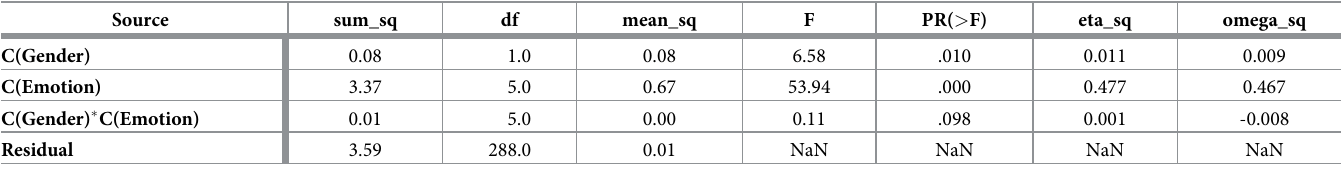
Table 15. Descriptive table for two-way ANOVA for Phase 2(for rater gender).